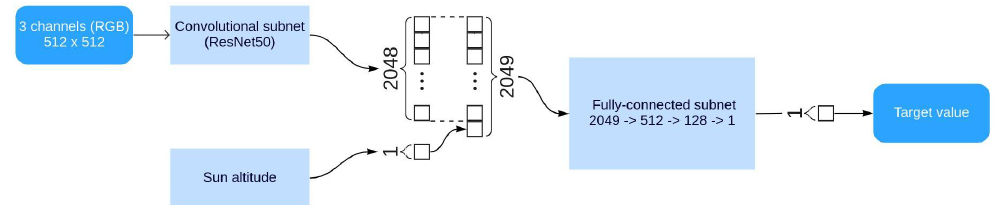
Figure 5. Architecture of a CNN we exploited in our study. Here, with numbers, we present the shapes of input data or activation